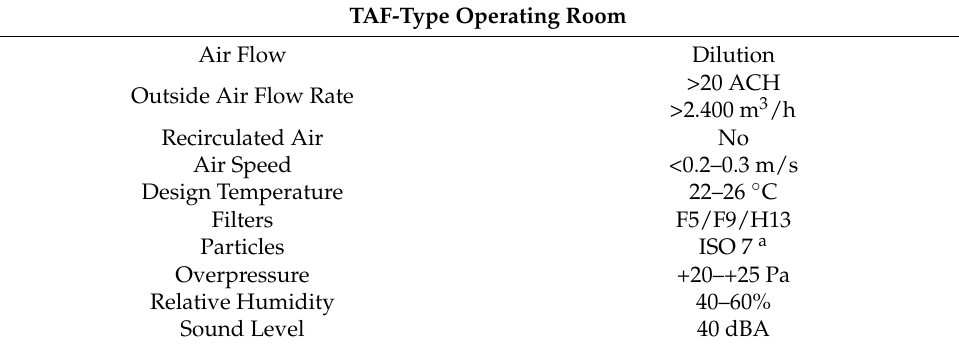
Table 3. OR Requirements According to UNE 100713.